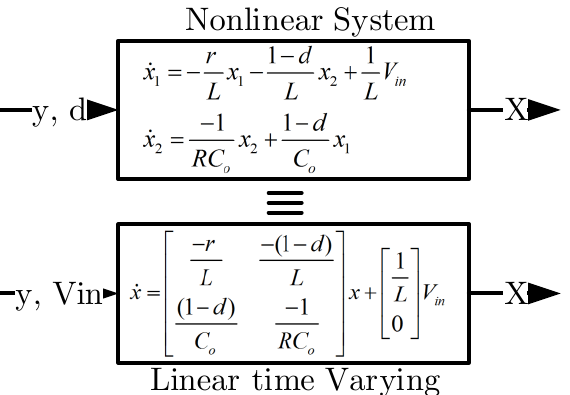
Figure 3. In order to estimate the state vector X , two explanations for boost converter modeling from the viewpoint of observer design exist. The first is a non-linear model where y and d are observer inputs, and the second is a linear time-varying model where y and V in are observer